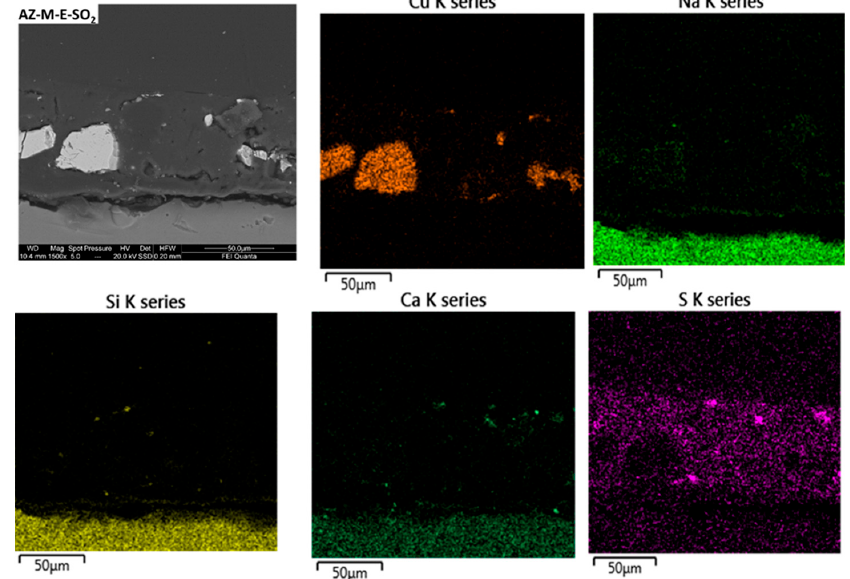
Figure 9. Maps showing the distribution of chemical elements (Cu, Na, Si, Ca, and S) in an area of the cross section of the SO 2 aged AZ-M-E paint obtained by scanning electron microscopy with microanalysis (SEM-EDS).